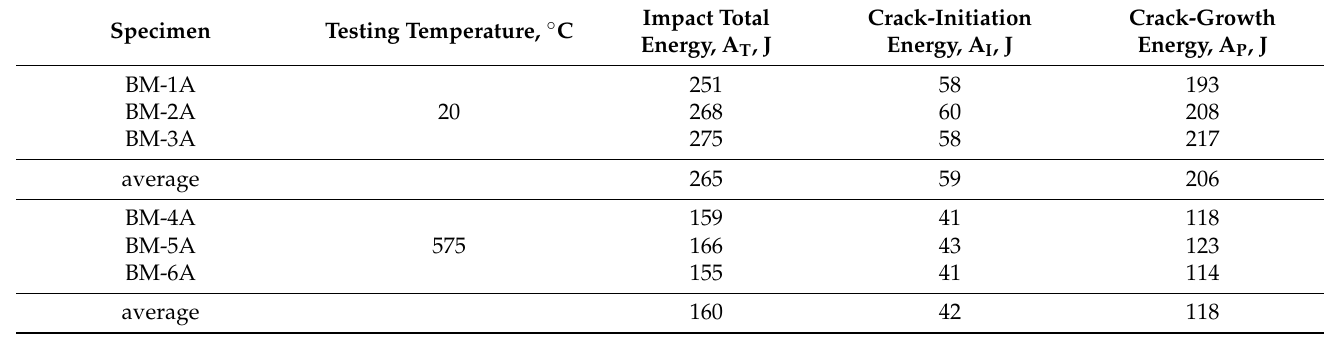
Table 4. Results of Charpy testing—SA 387 Gr. 91 BM.